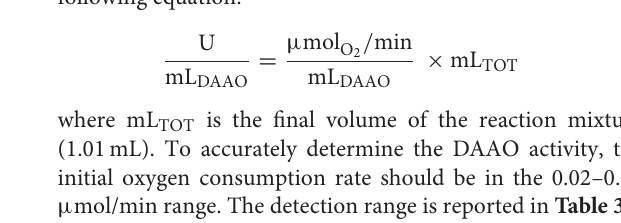
7. Substrates: D-amino acid solutions (at different concentrations, depending on the corresponding K m values) in 75 mM disodium pyrophosphate buffer, pH